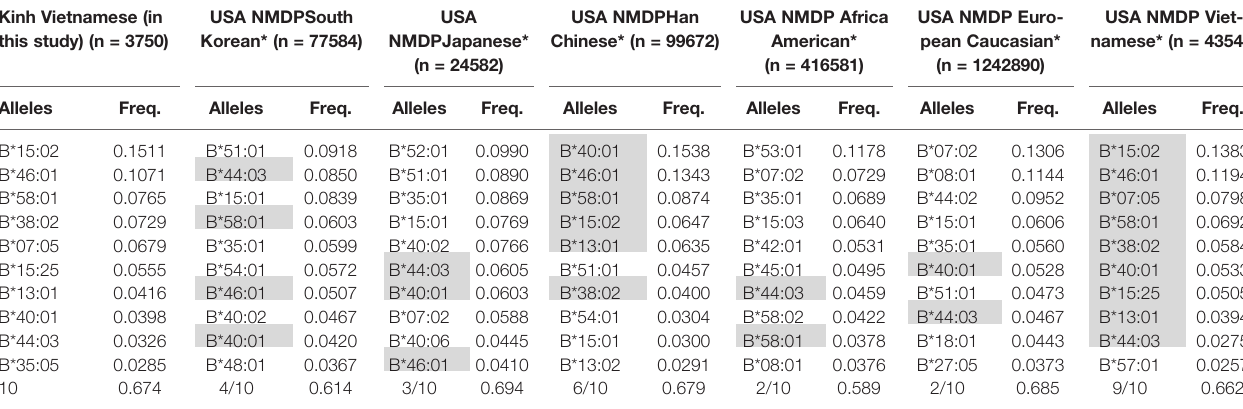
*From the allele frequency net, the grey background indicates common alleles shared between the Kinh Vietnamese and other populations.